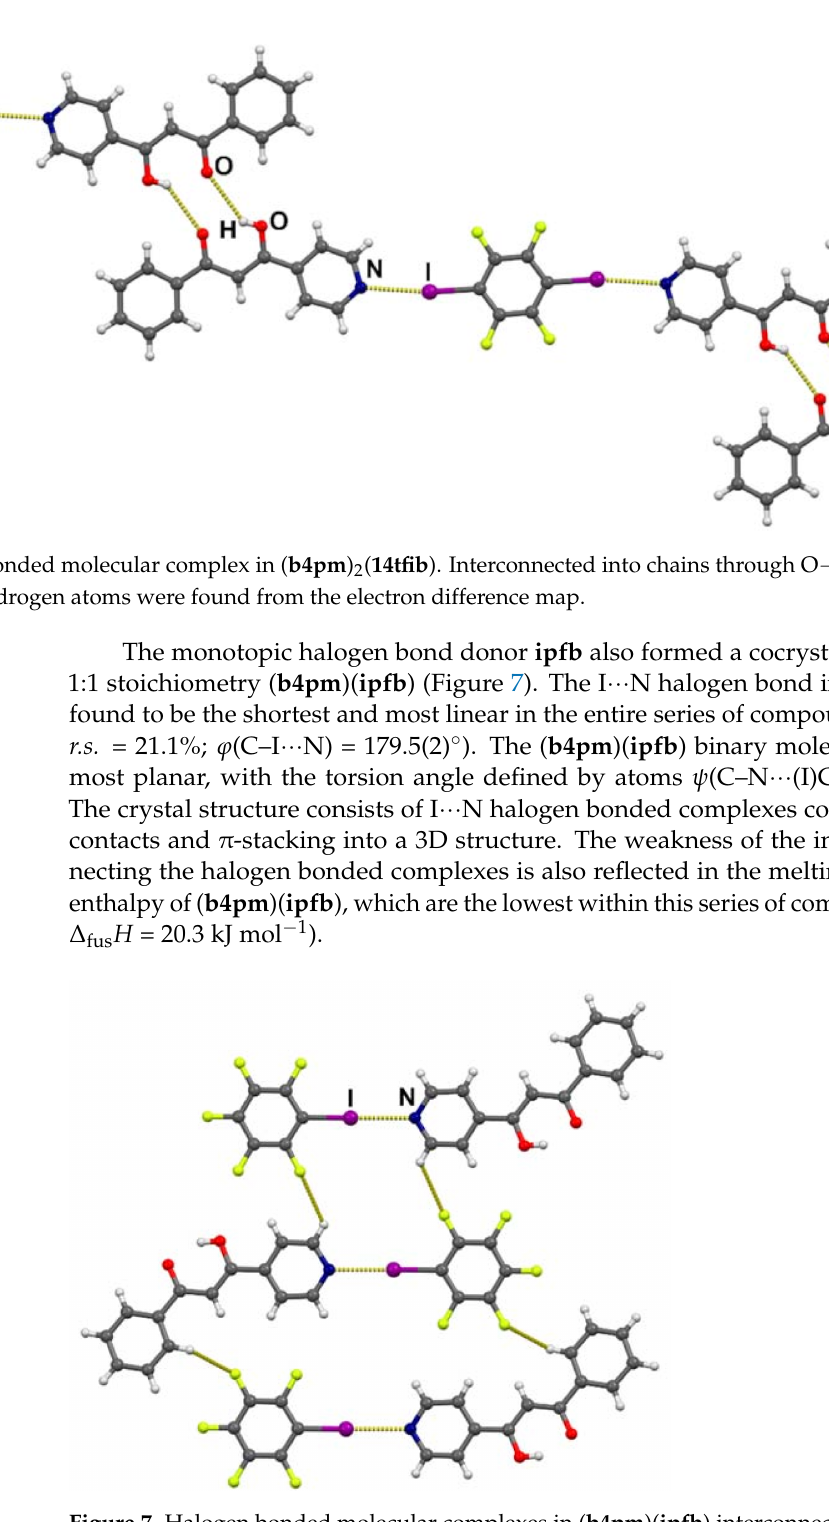
Figure 7. Halogen bonded molecular complexes in ( b4pm )( ipfb ) interconnected by C–H ··· F hydro- gen bonds into chains. Hydroxyl hydrogen atoms were found from electron difference